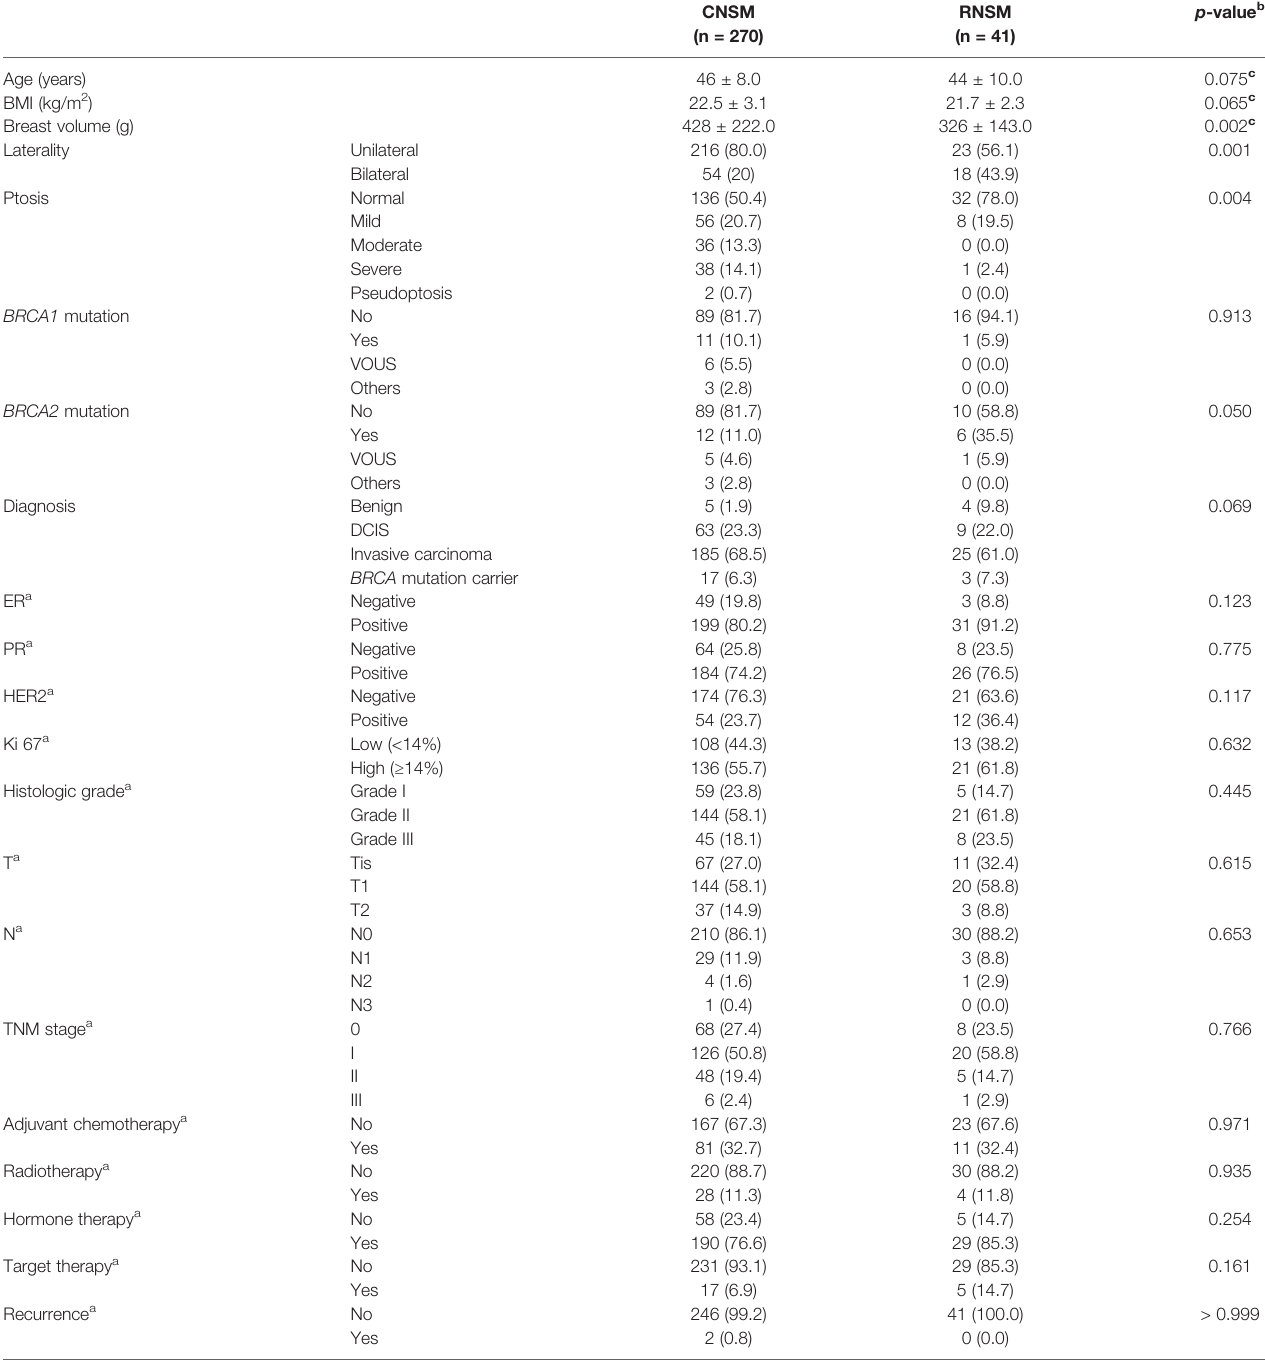
TABLE 1 | Clinicopathologic characteristics of the study